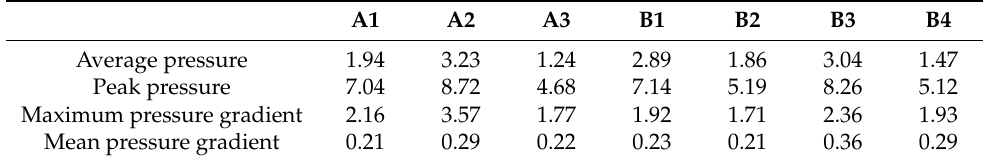
Table 4. Partition ideal body pressure distribution index. Figure 4. Pillow partition.